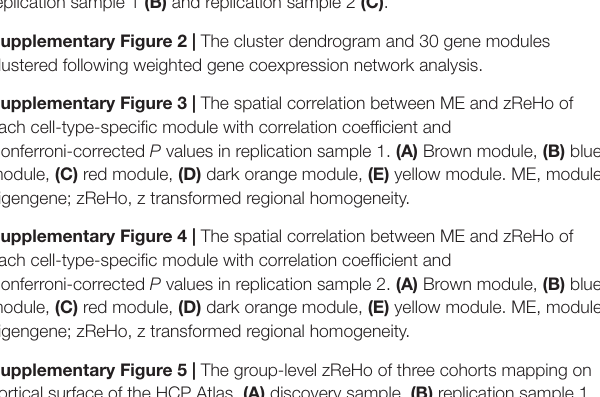
Supplementary Figure 2 | The cluster dendrogram and 30 gene modules clustered following weighted gene coexpression network analysis. Supplementary Figure 3 | The spatial correlation between ME and zReHo of each cell-type-specific module with correlation coefficient and Bonferroni-corrected P values in replication sample 1. (A) Brown module, (B) blue module, (C) red module, (D) dark orange module, (E) yellow module. ME, module eigengene; zReHo, z transformed regional homogeneity. Supplementary Figure 4 | The spatial correlation between ME and zReHo of each cell-type-specific module with correlation coefficient and Bonferroni-corrected P values in replication sample 2. (A) Brown module, (B) blue module, (C) red module, (D) dark orange module, (E) yellow module. ME, module eigengene; zReHo, z transformed regional homogeneity. Supplementary Figure 5 | The group-level zReHo of three cohorts mapping on cortical surface of the HCP Atlas. (A) discovery sample, (B) replication sample 1, (C) replication sample 2. HCP, Human Connectome Project; L, left hemisphere; R, right hemisphere; zReHo, z transformed regional homogeneity. Supplementary Figure 6 | The ME values of cell-type-specific modules mapping on cortical surface of the HCP Atlas. (A) ME brown, (B) ME blue, (C) ME red, (D) ME darkorange, (E) ME yellow. HCP, Human Connectome Project; L, left hemisphere; ME, module eigengene; R, right hemisphere. Supplementary Table 1 | The 820 neocortical sample coordinates with the corresponding HCP brain regions. HCP, Human Connectome Project; MNI, Montreal Neurological Institute; Parcel Index, parcelation index. Supplementary Table 2 | The normality test results of ME for all modules across neocortical regions. Note: The Kolmogorov-Smirnov test was applied to check the normality of ME for modules across neocortical regions. ME, module eigengene. Supplementary Table 3 | The GWAS datasets of common brain disorders involved in this study. GWAS, genome-wide association studies; IGAP,